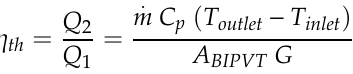
Table 3. The thermal efficiency of an air-type BIPVT collector.